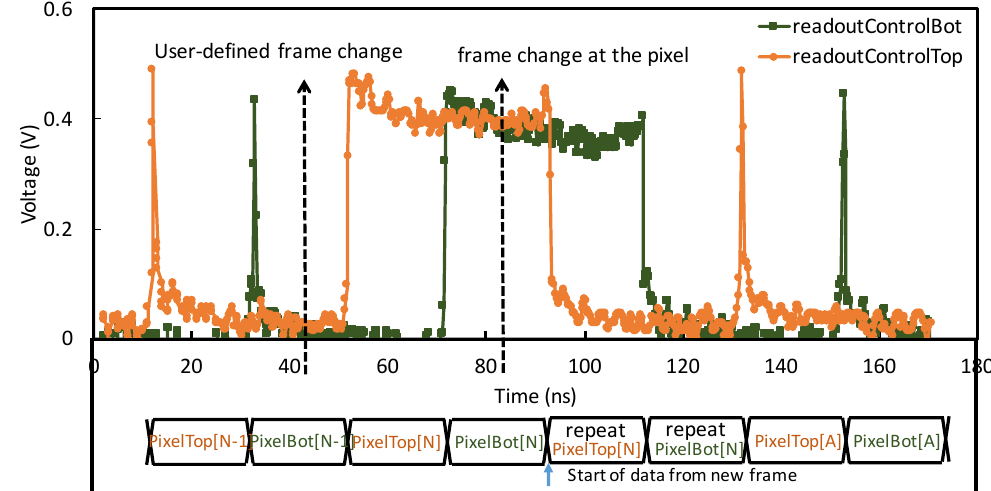
Figure 11. Frame clock change for the DCT operating at 1 GHz. A frame change at the positive edge of frameClk is issued at approximately 40 ns, initiating the new frame at approximately 90 ns, with the DCT operating at 1